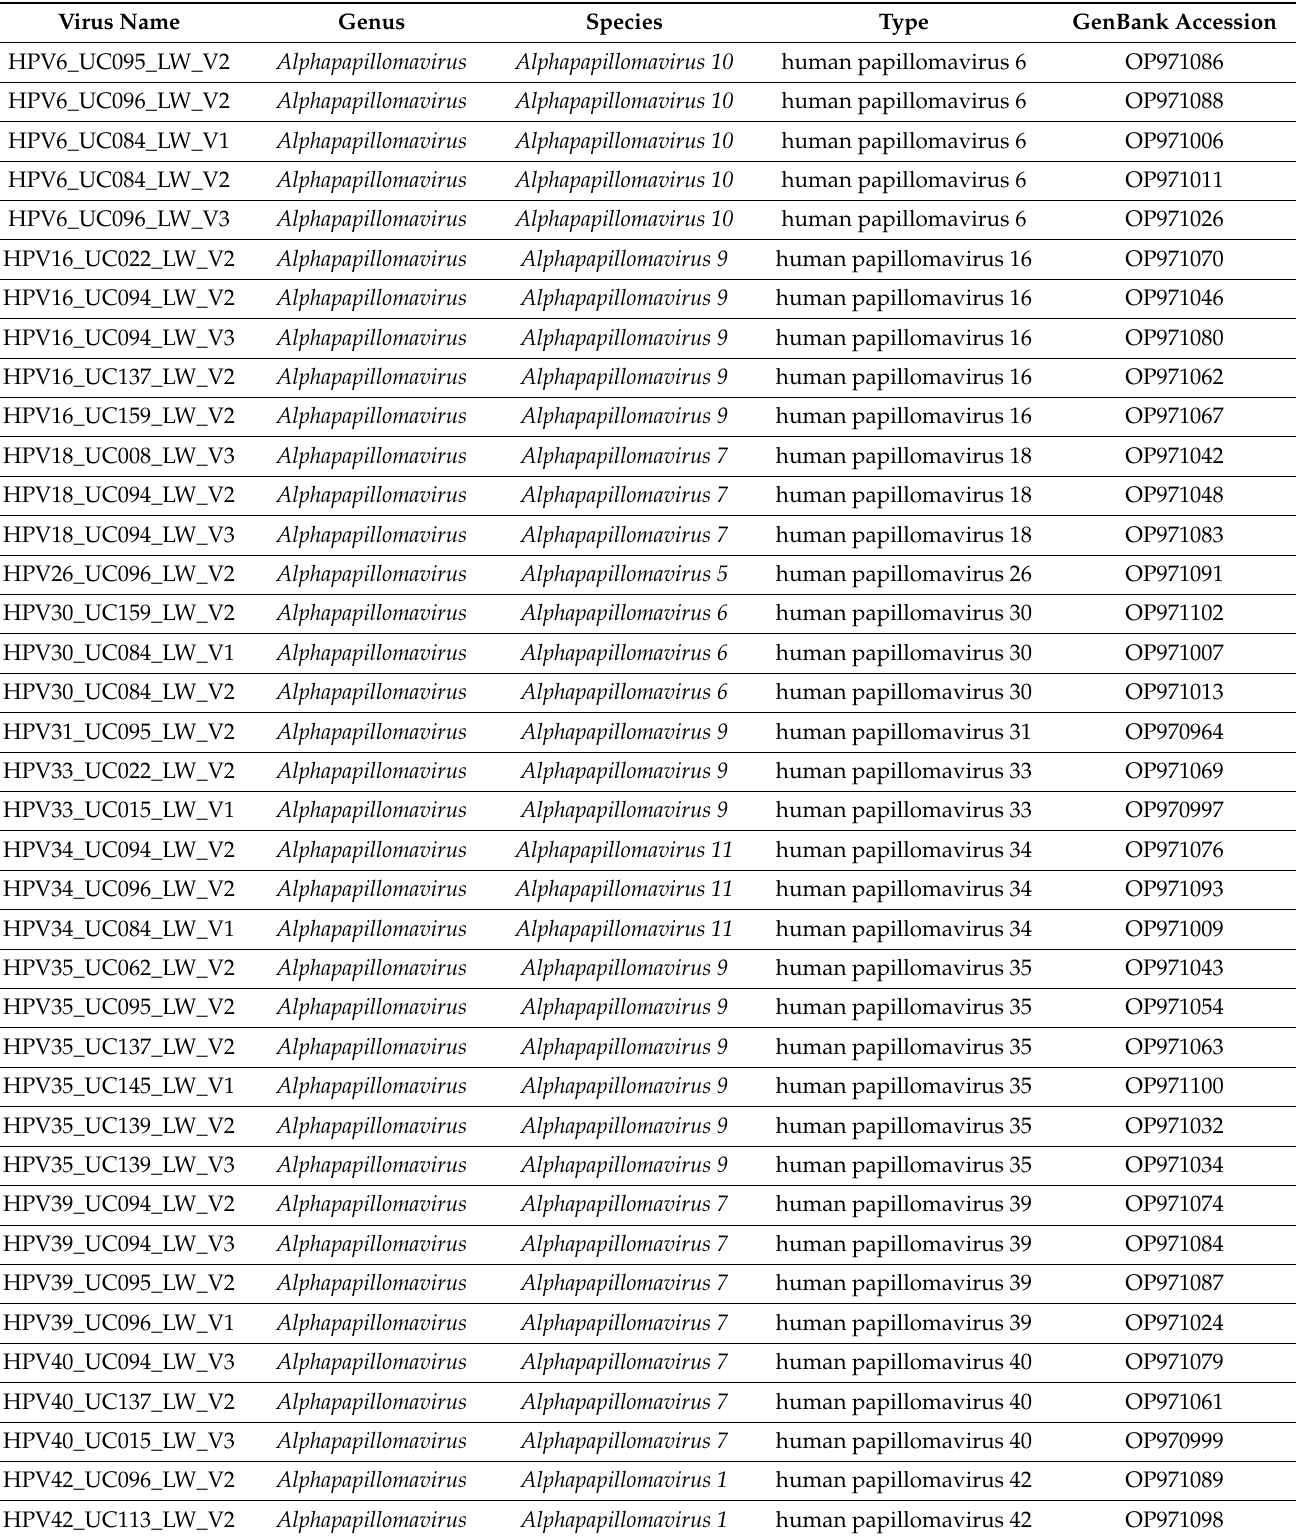
Table 2. List of identified complete HPV genomes determined in this